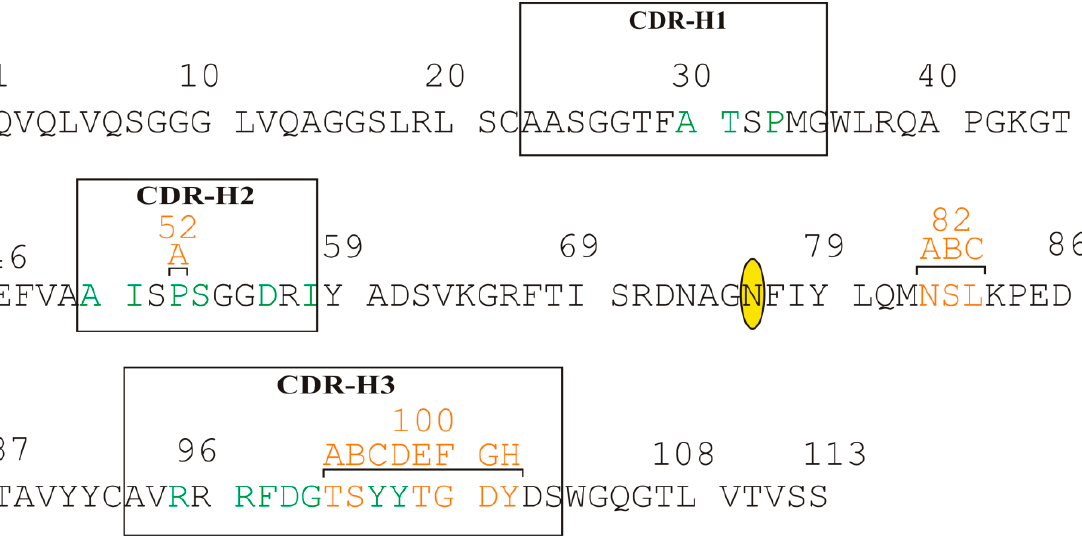
Figure 2. Amino acid sequence of anti-IL-17A-76 (the numbering of amino acids is presented in accordance with the Kabat Database). The CDR regions are shown with frames. Amino acids involved in the interaction with IL-17A are shown in green. Point mutation Y76N is shown by ellipse.